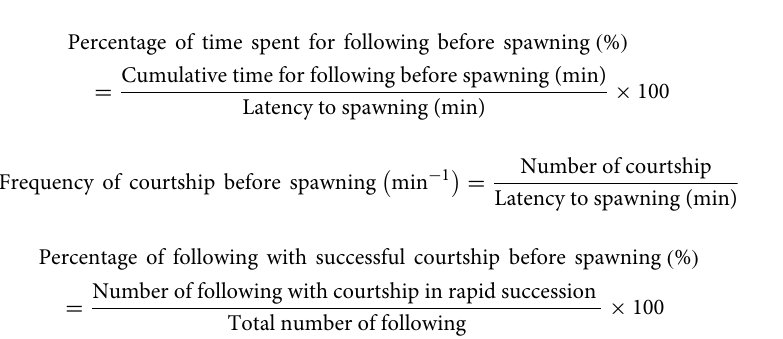
Figure 3. Conceptual diagram of Ethogramer . ( a ) Diagram that represents some indices for setting that filled in worksheet- “ Sheet1 ” are reflected to each function for behavioral annotation. Data in columns- “Repertoire Name” and “Continuous/Intermittent” in worksheet- “ Sheet1 ” configure the setting of columns for annotations of the timing of the behavior in worksheet- “ Sheet2 …”. Key assigning is performed by filling in the letters in column- “Key”. Available keys are shown in Supplementary Information. Color information of the cells in column- “Color” are reflected in drawing raster plots. Filled in Data in cell- “Time (s)” is defined the length of raster plots. After setting these indices, it enabled to perform behavioral annotation by pressing assigned keys. ( b ) Image representing the example of the text-based data exported in EPS format (left, “Text data”) and the graphical image actually outputted when opened by vector graphics editor (right, “Graphical output”). Time information of each behavioral event obtained by pressing keys (for example: a behavioral event is observed from t to t + Δt) are substituted like in the left box, and these text-based data define the coordinates for drawing a square in a raster plot like in the right